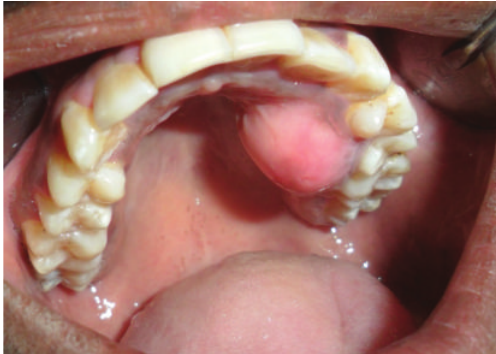
Figure 1: A clinical view of di ff use, bony hard swelling in the max- illary left region of hard palate.